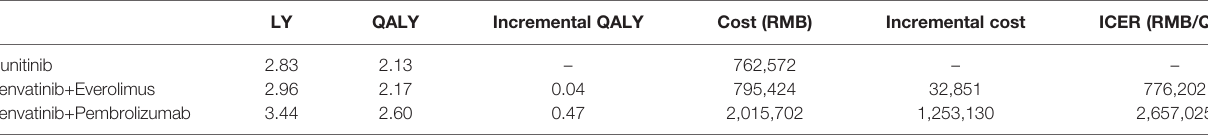
TABLE 2 | Results of the base-case analysis.